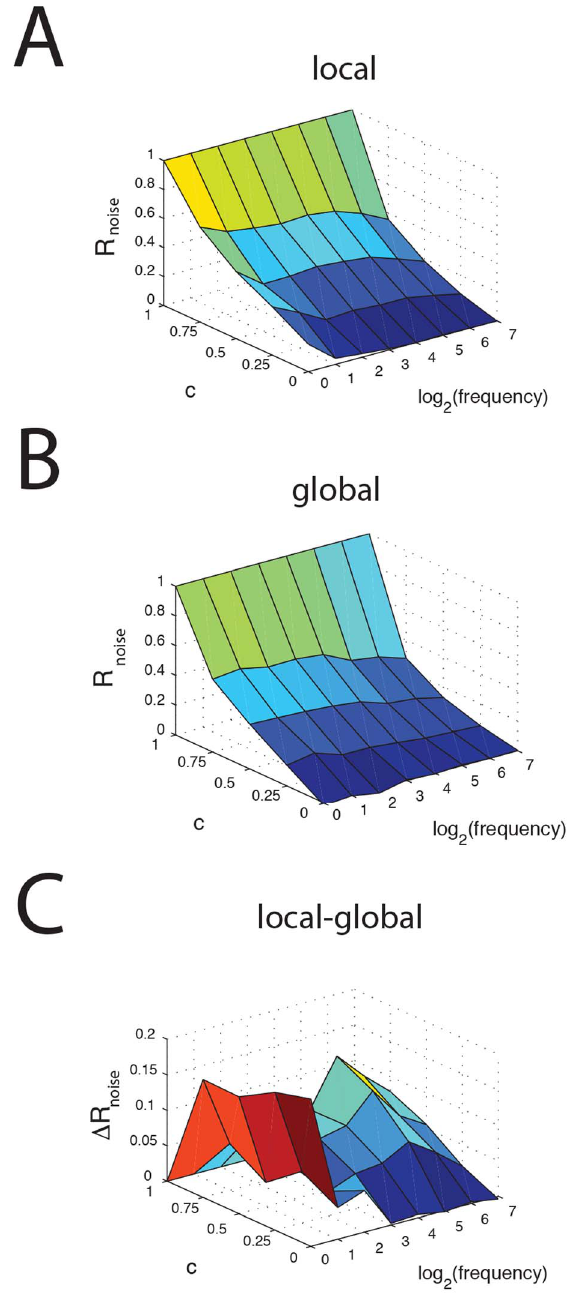
Fig. 6. Reduction of noise correlations by granule cell activity is dependent on stimulation frequency. A ) Noise correlation coefficient as a function of c and the sinusoidal stimulation frequency f for local stimulation. B ) Noise correlation coefficient as a function of c and f for global stimulation. C ) Reduction (local-global) in noise correlation coefficient as a function of c and f .